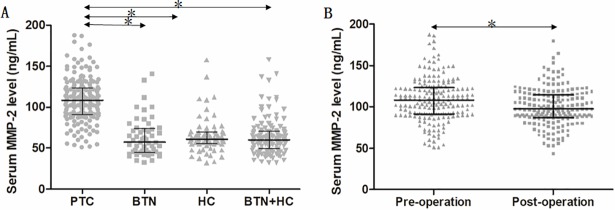
Serum MMP-2 concentrations of subjects.A Preoperative serum MMP-2 concentration in patients with PTC or BTH and in HCs. B preoperative versus postoperative serum MMP-2 concentration in the same patients with PTC. PTC, papillary thyroid carcinoma; BTN, benign thyroid nodule; HC, healthy control. The middle black horizontal lines indicate the median value of measurements, and the error bars indicate interquartile ranges. *p<0.001.